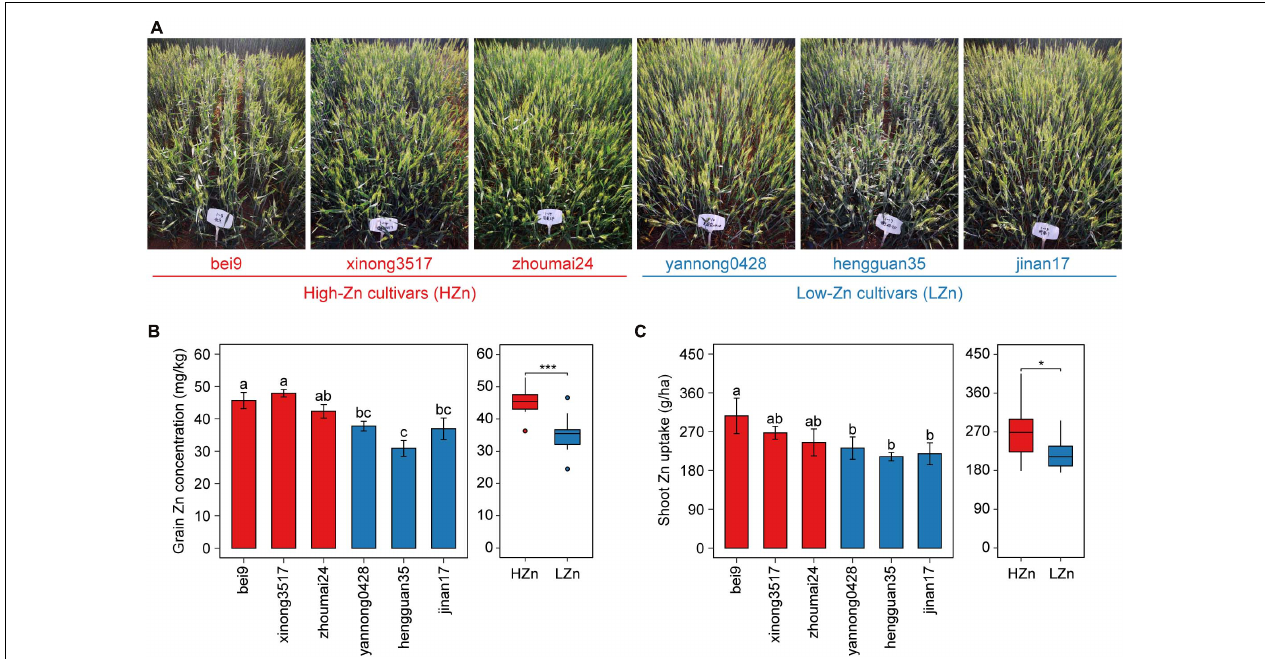
FIGURE 1 | Phenotypic data of the six wheat cultivars grown in calcareous soil. Photographs taken at anthesis (A) , grain Zn concentration (B) , and shoot Zn uptake (C) at maturity of three high-Zn (HZn) and three low-Zn (LZn) cultivars with average grain Zn concentrations higher or lower than the Zn biofortification target 40 mg kg - 1 . In the left panel of (B,C) , the error bars stand for mean ± standard error ( n = 4), and different lowercase letters indicate significant differences among cultivars (ANOVA, Duncan, P < 0.05). In the right panel of (B,C) , the inner horizontal lines, and bottom and top of boxes indicate the medians, and 25th and 75th percentiles, respectively; the lower and upper whiskers extend to the minimum and maximum of the data excluding the outliers denoted by dots, respectively; and asterisks indicate significant differences between HZn ( n = 12) and LZn ( n = 12) ( t -test, * P < 0.05, *** P <